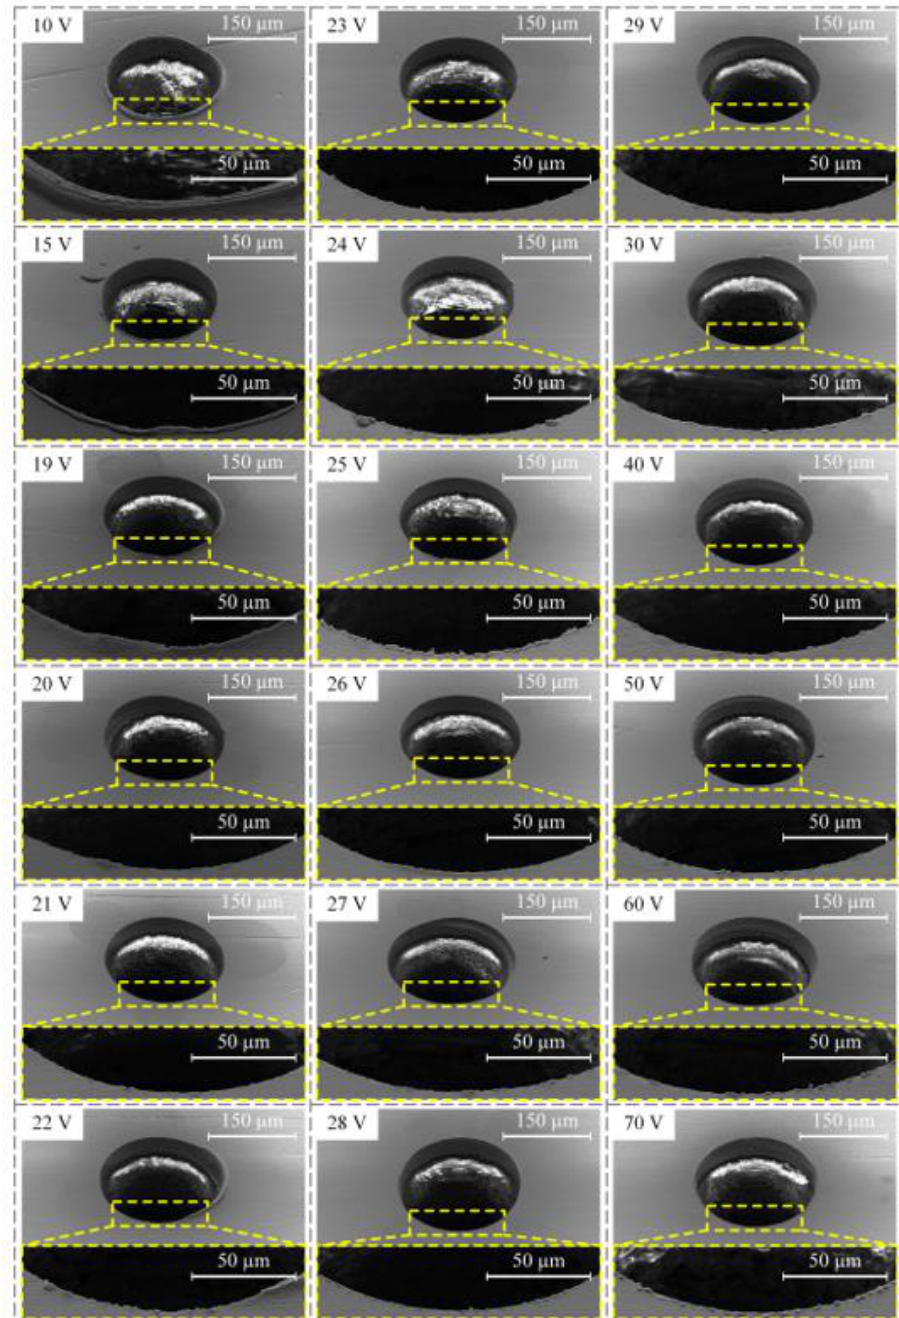
Figure 6. Influence of machining voltage on the machining quality of micro-holes.